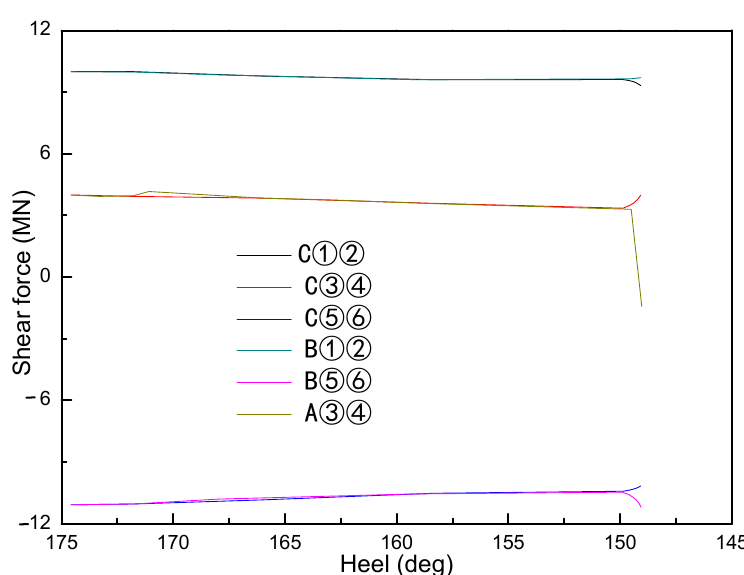
Figure 4. Variation of shear force under case Ⅱ .